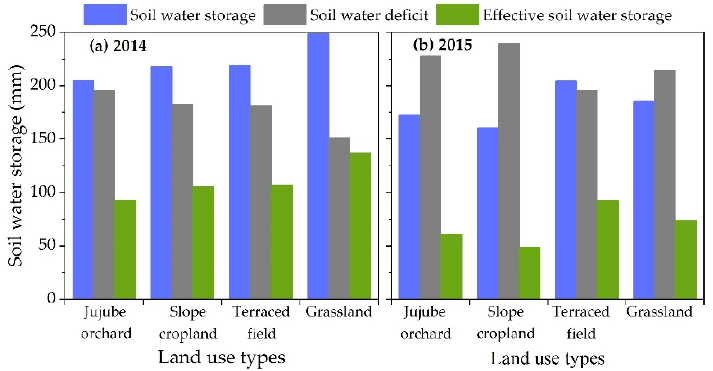
Figure 5. Average soil water storage, soil water deficit, and effective soil water storage in the 0–160 cm soil layer during the 2014 ( a ) and 2015 ( b ) growing seasons for various land uses.